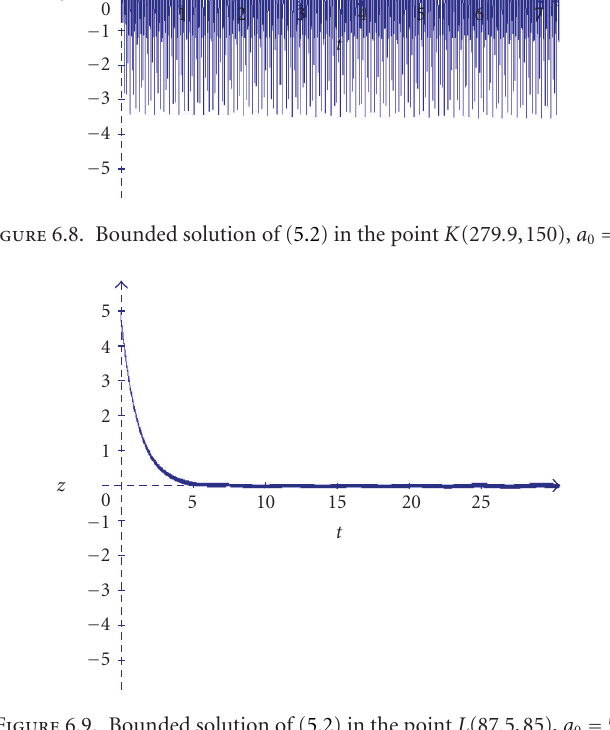
Figure 6.9 . Bounded solution of (5.2) in the point L (87 . 5,85), a 0 =